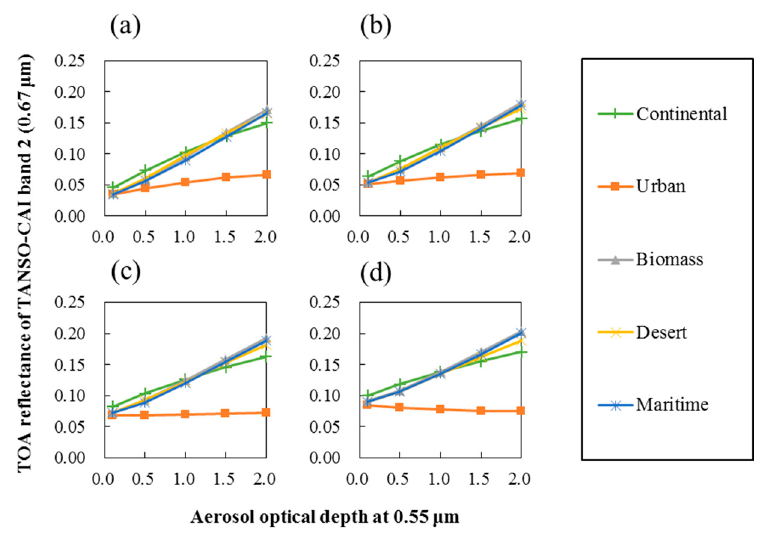
Figure 13. TANSO-CAI TOA reflectance as a function of AOD and surface reflectance at 0.67 µm under different aerosol models. The assumed surface reflectances are: ( a ) 0.02; ( b ) 0.04; ( c ) 0.06; and ( d ) 0.08. Simulation is performed under the observation geometric conditions with solar zenith angle = 30°, satellite zenith angle = 30°, and relative azimuth angles = 180°.